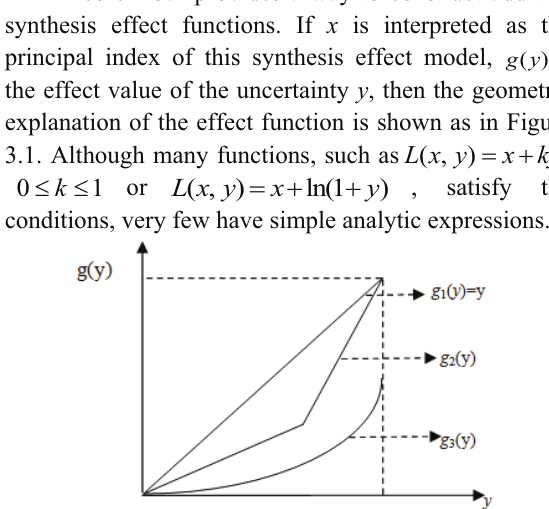
Figure 3.1. The geometric explanation of additive effect metric